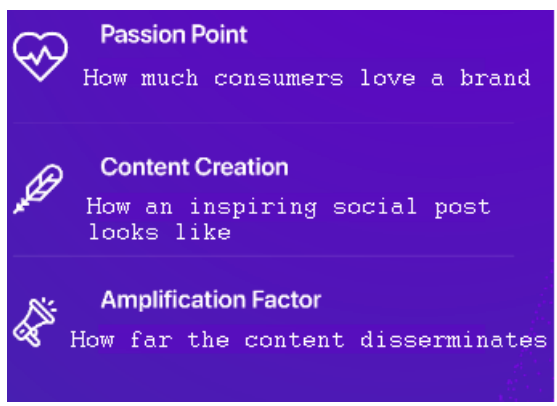
Figure 1. The influential measures of the ADVO system.